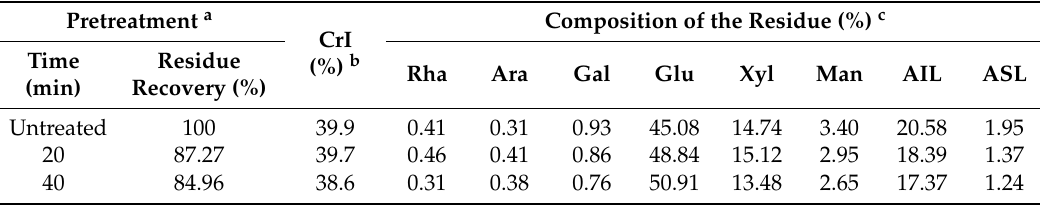
Table 1. Chemical composition of the poplar wood untreated and pretreated with [Emim]Ac. Pretreatment a